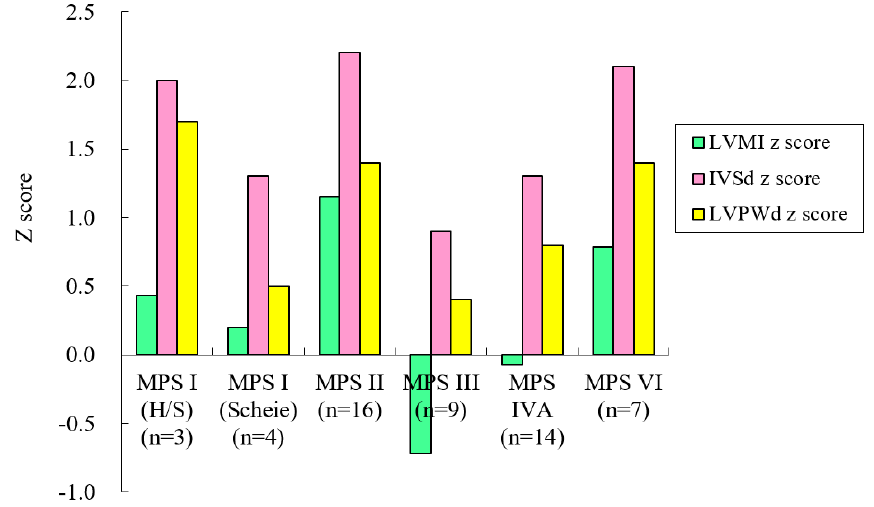
Figure 1. The z scores of LVMI, IVSd, and LVPWd by MPS type in the 53 patients. MPS, mucopolysaccharidosis; LVMI, left ventricular mass index; IVSd, interventricular septum thickness in diastole; LVPWd, left ventricular posterior wall thickness in diastole; H/S: Hurler-Scheie.